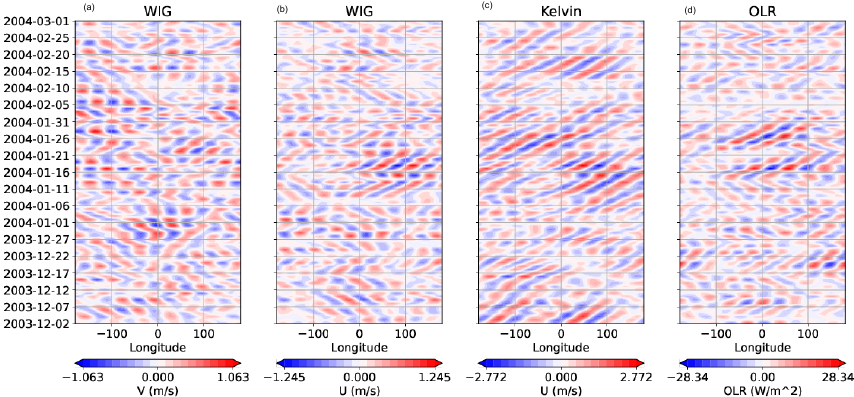
Figure 17. Hovmöller diagram of ( a ) the 200 hPa meridional wind field due to westward inertio- gravity waves, ( b ) the 200 hPa zonal wind field due to westward inertio-gravity waves, ( c ) the 200 hPa zonal wind field associated with Kelvin waves, and ( d ) the OLR field. All fields were averaged over the latitudinal belt of 5 ◦ S–5 ◦ N and filtered in space and time by removing signals with periods higher than 10 days and keeping only those signals with zonal wavenumbers between 4 and 6.